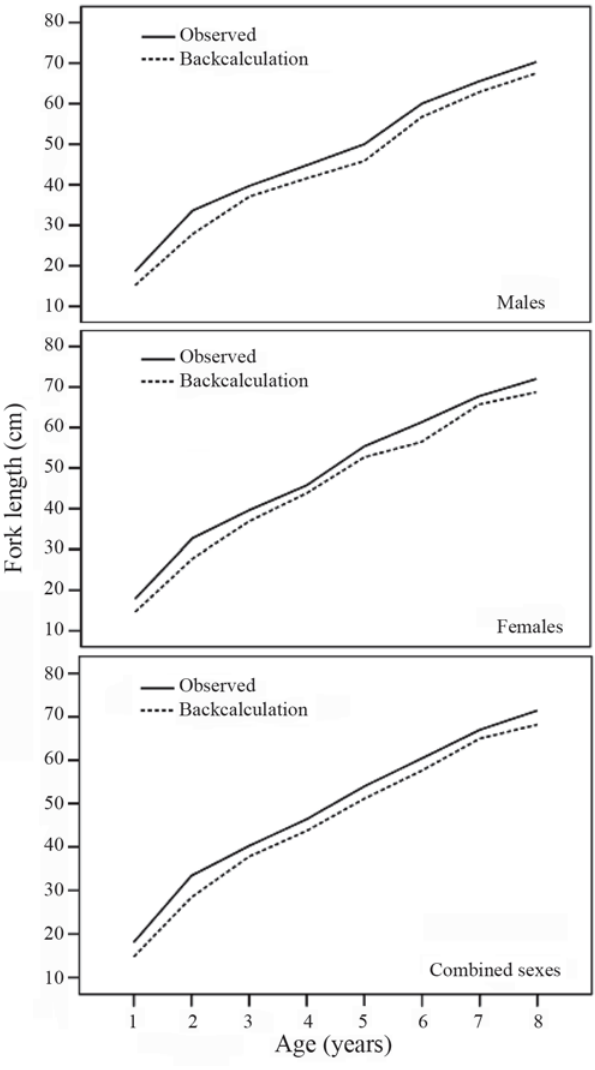
Fig. 6. Mean observed and backcalculated lengths of Scomberomorus brasiliensis at different catch ages for males, females and combined sexes in the northeastern